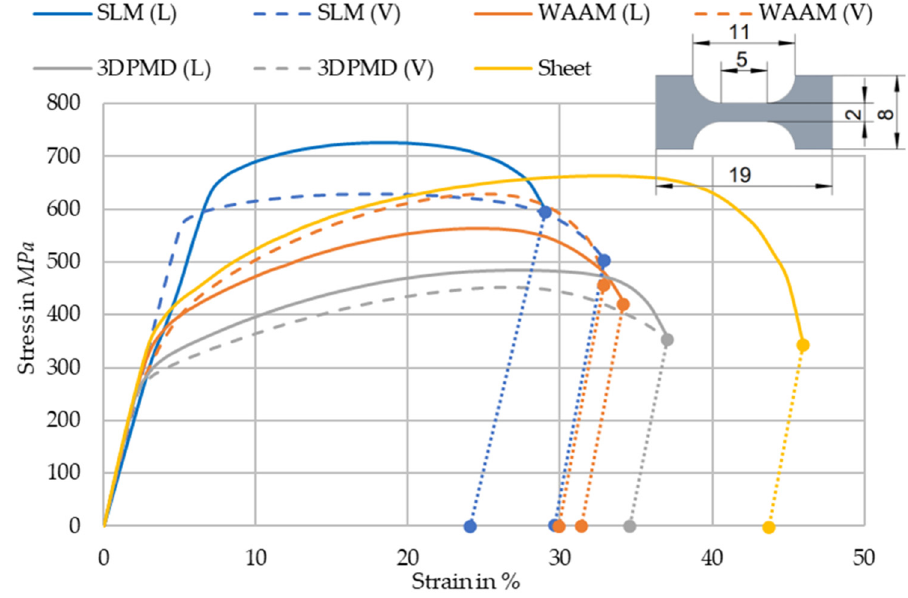
Figure 7. Tensile tests of the different additive manufacturing processes.